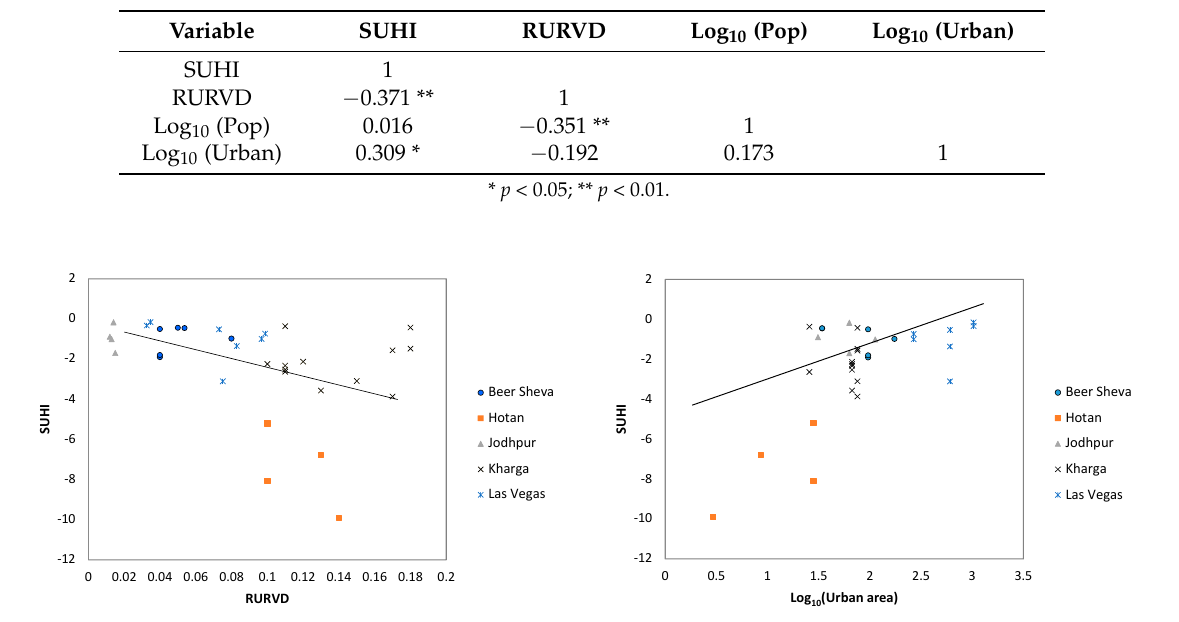
Table 4. Kendall’s τ for SUHI, RURVD, logarithm of population, and logarithm of urban area.